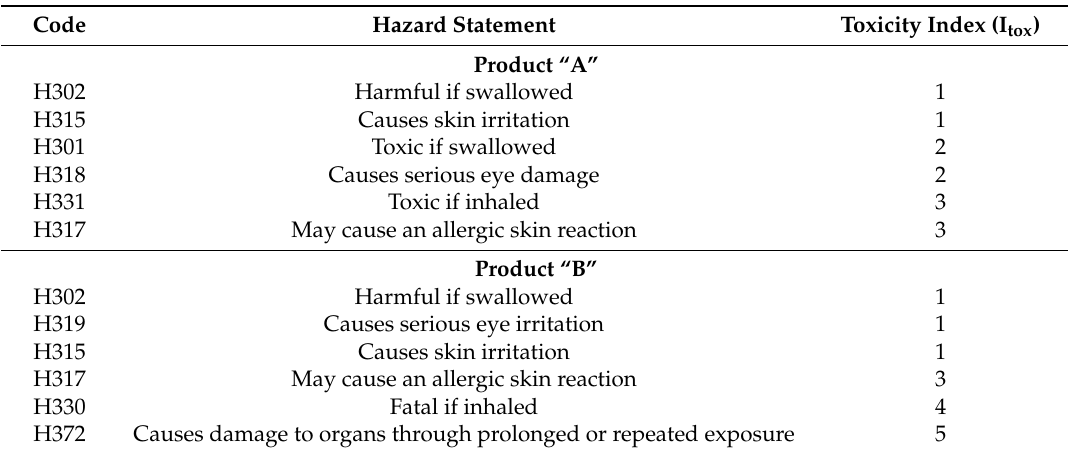
Table 13. Evaluation of the Toxicity Index of both products.